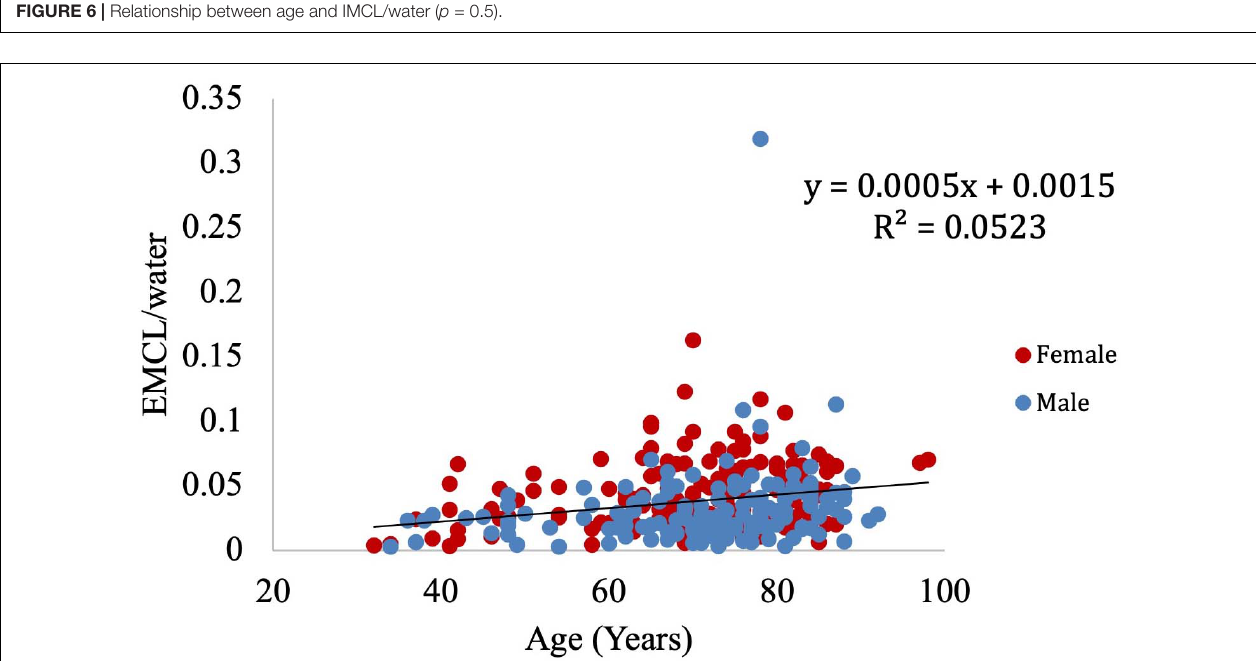
FIGURE 7 | Relationship between age and EMCL/water ( p <